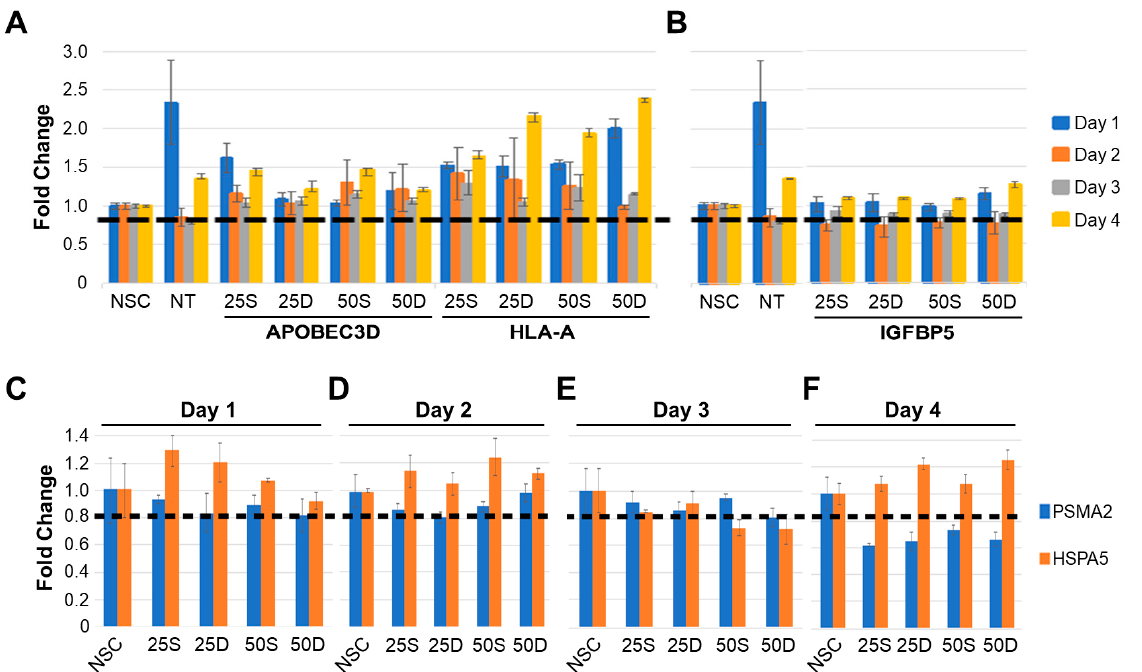
Figure 6. Optimization of siRNA treatments, number of siRNA treatments and time kept in the siRNA treatment in U251 cells. The dashed bar represents 80% of cell viability compared to the non-silencing scrambled control (NSC). Cells were plated at 30–40% confluency to ensure that by day 4, the wells were close to 95% confluent and overcrowding was not occurring. ( A ), Cell viability results for U251 cells treated with APOBEC3D and HLA-A siRNA for 1–4 days. Error bars represent standard deviations. ( B ), Cell viability results for U251 cells treated with IGFBP5 siRNA for 1–4 days. Error bars represent standard deviations. UT represents cells that have not been treated with any siRNA at all, while NSC represents cells that have been treated with non-silencing control siRNA. UT condition is only included to see if any changes in cell viability occur due to presence of siRNA itself. Cell viability results for U251 cells treated with PSMA2 or HSPA5 siRNA treatment for ( C ), 1 day; ( D ), 2 days; ( E ), 3 days; and ( F ), 4 days. Blue bars indicate PSMA2 siRNA treatment cell viabilities; orange bars indicate HSPA5 siRNA treatment cell viabilities. S: single siRNA treatment; D: double siRNA treatment. Error bars represent standard deviations.